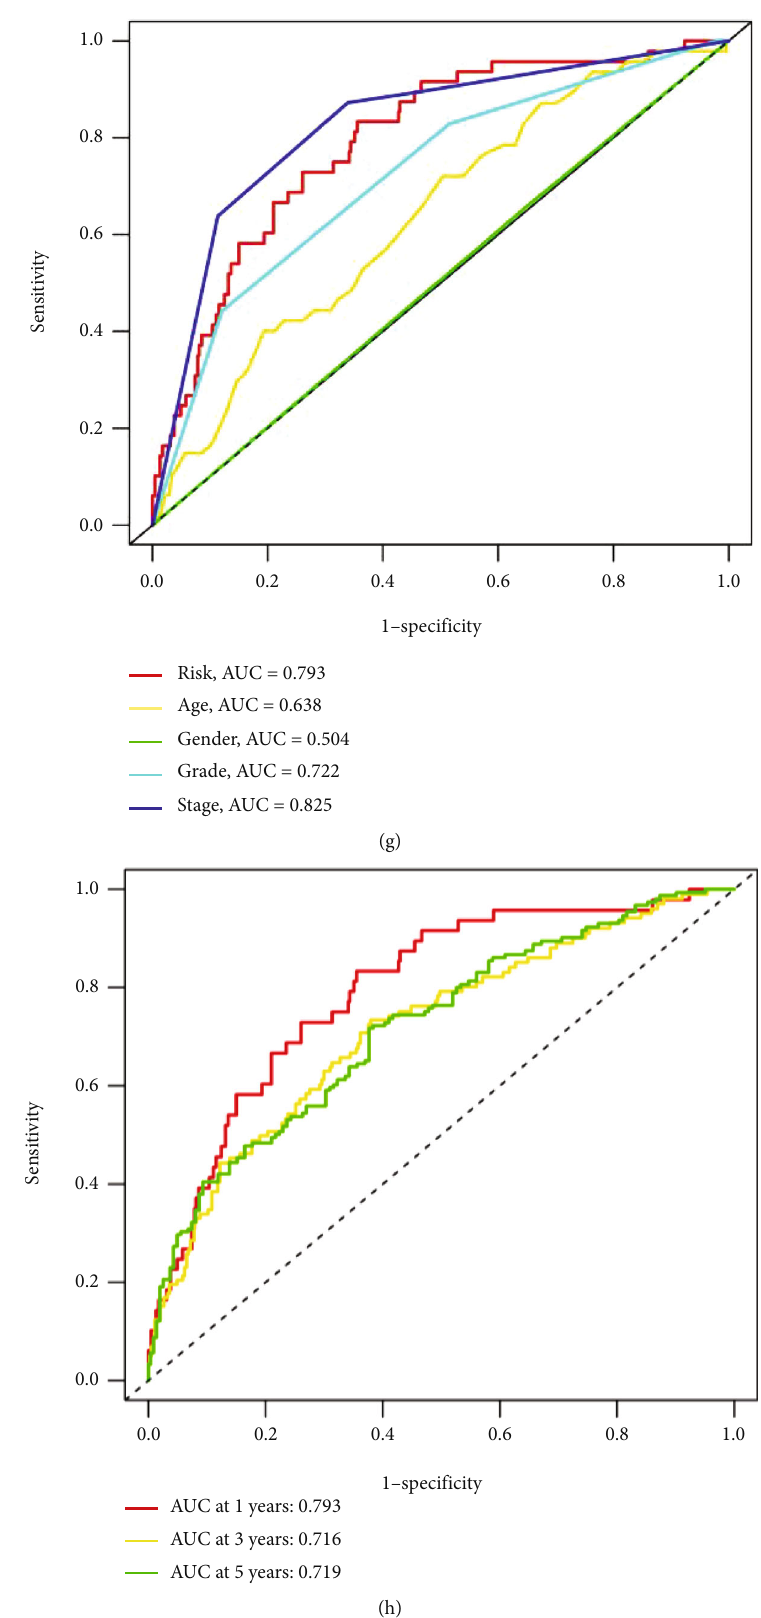
Figure 5: Validation of risk signature power and independent prognostic factors. (a), (c), and (e) Uni-Cox and (b), (d), and (f) multi-Cox analysis of clinicopathological factors and the risk scores in the training set, testing set, and the whole set. (g) The area under the curve (AUC) and the receiver operating characteristic (ROC) curves of di ff erent factors. (h) The AUC under the 1-, 3-, and 5-year ROC curves of risk